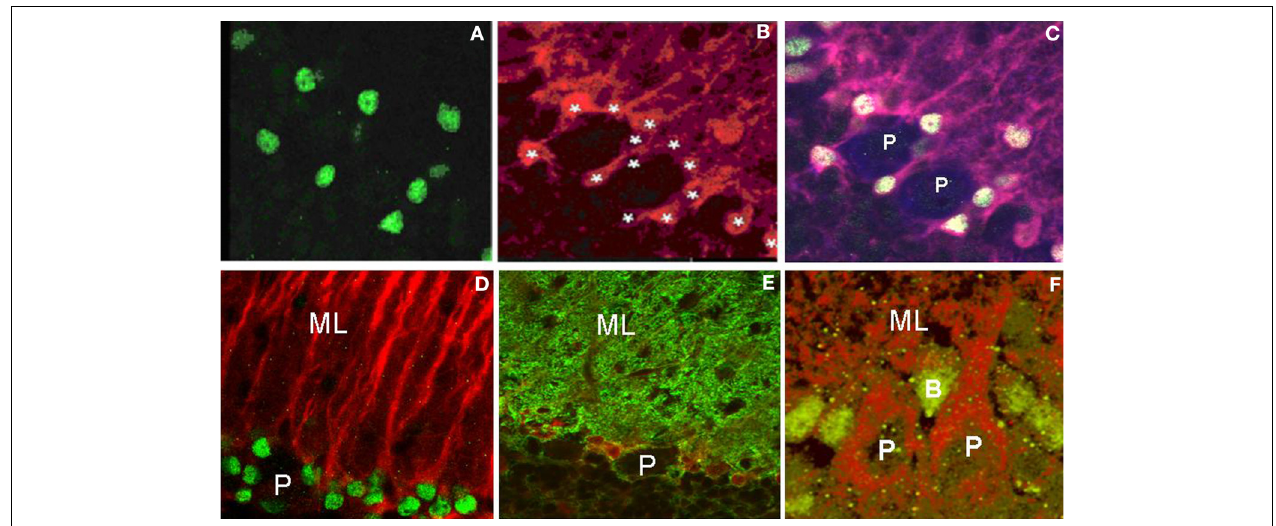
FIGURE 2 | Panels (A) and (B) are fl uorescently labeled images from 15-day-old cerebellum using cleaved caspase-3 and S-100b immunohistochemistry visualized with Alexa 488 and Alexa 546, respectively. It is apparent that caspase-3 labels the nuclei of Bergmann glia. Asterisks identify the Bergmann glia in which approximately 60% contain cleaved caspase-3 immunoreactivity. Panel (C) is the triple labeled fl uorescent image of caspase-3 (Alexa 488), S-100b (Alexa 546) and calbindin (Alexa 633) to identify and quantitate the total number of Bergmann glia within each lobule at the different ages, surrounding the Purkinje neurons. Panel (D) is a double labeled image using cleaved caspase-3 and GFAP immunoreactivity